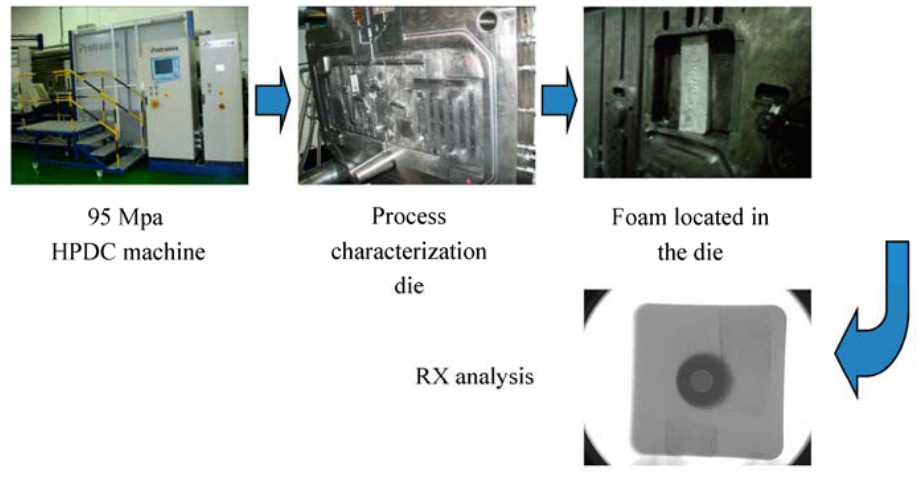
Figure 6. HPDC process in order to obtain the magnesium ‐ aluminium foam core composite.